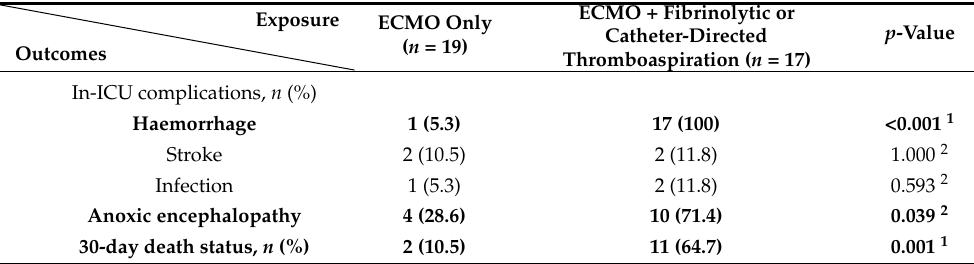
Table 5. ICU events (complications) and 30-day survival status between ECMO-treated patients for massive PE versus ECMO + fibrinolytic